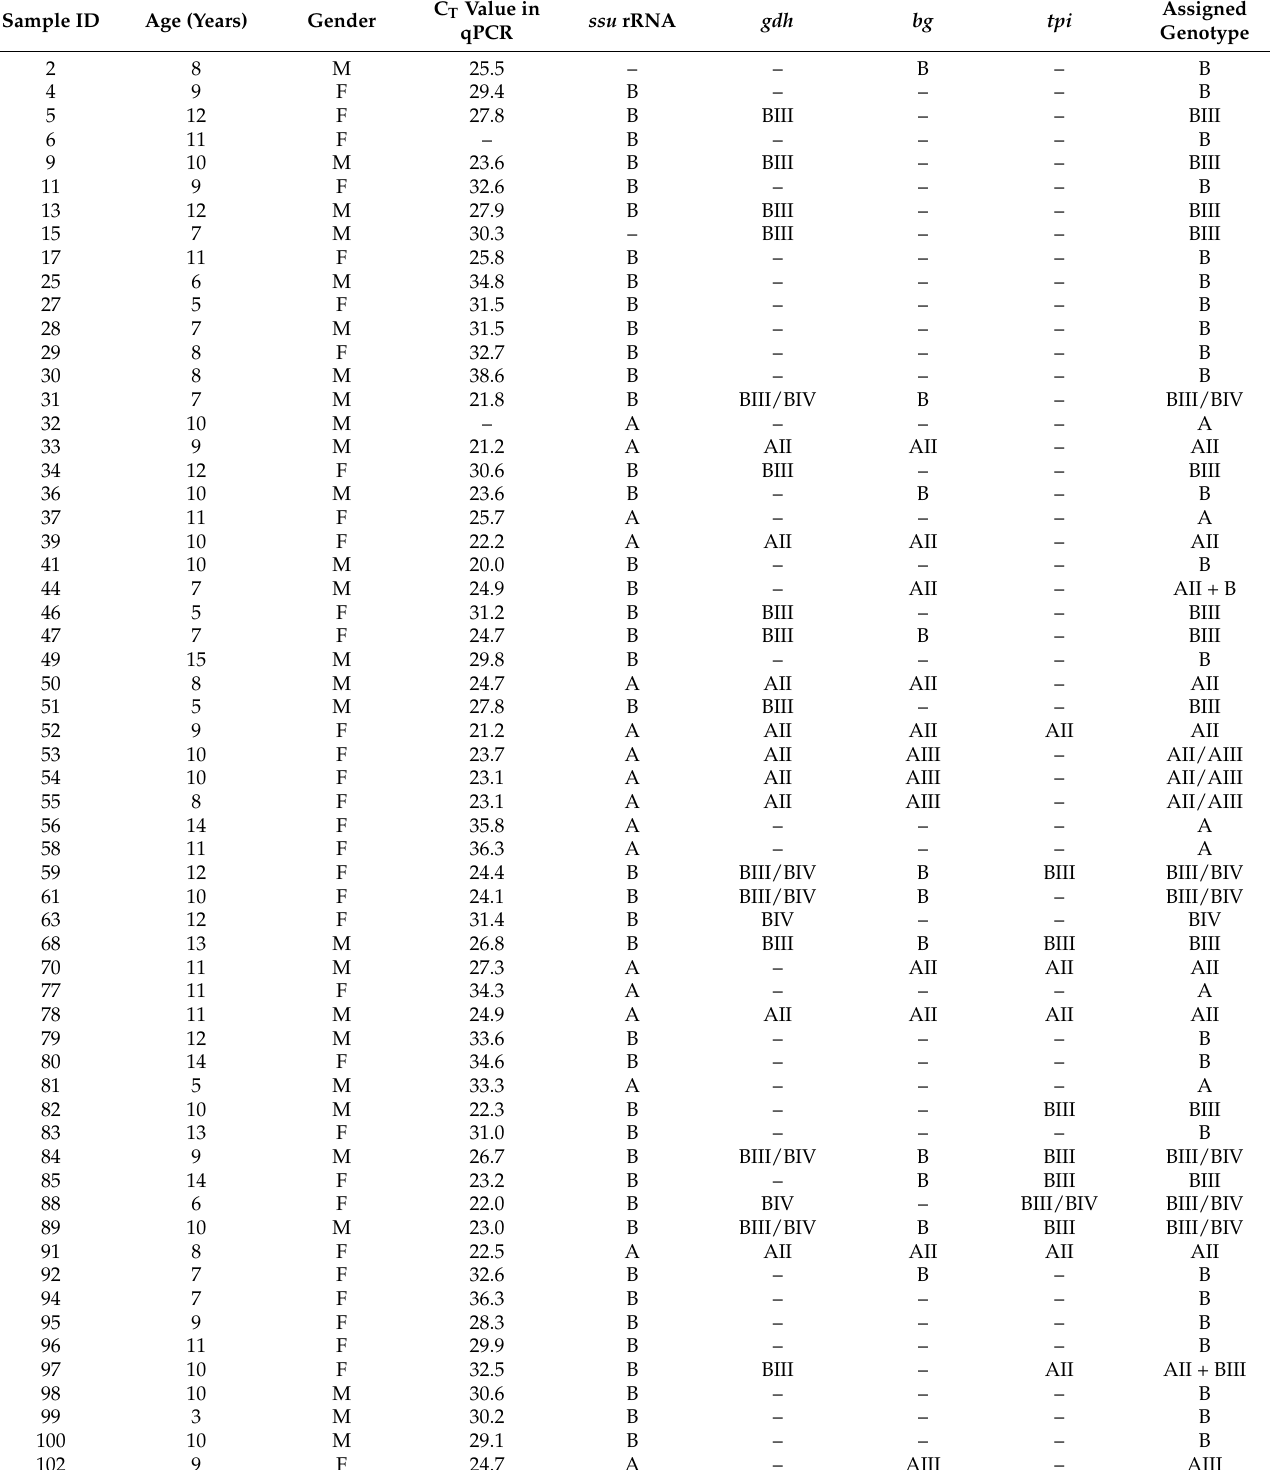
Table 3. Multilocus sequence typing results of the 60 G. duodenalis -positive samples of pediatric origin successfully genotyped at any of the four loci investigated in the present survey. The age and gender of the infected children are also shown.